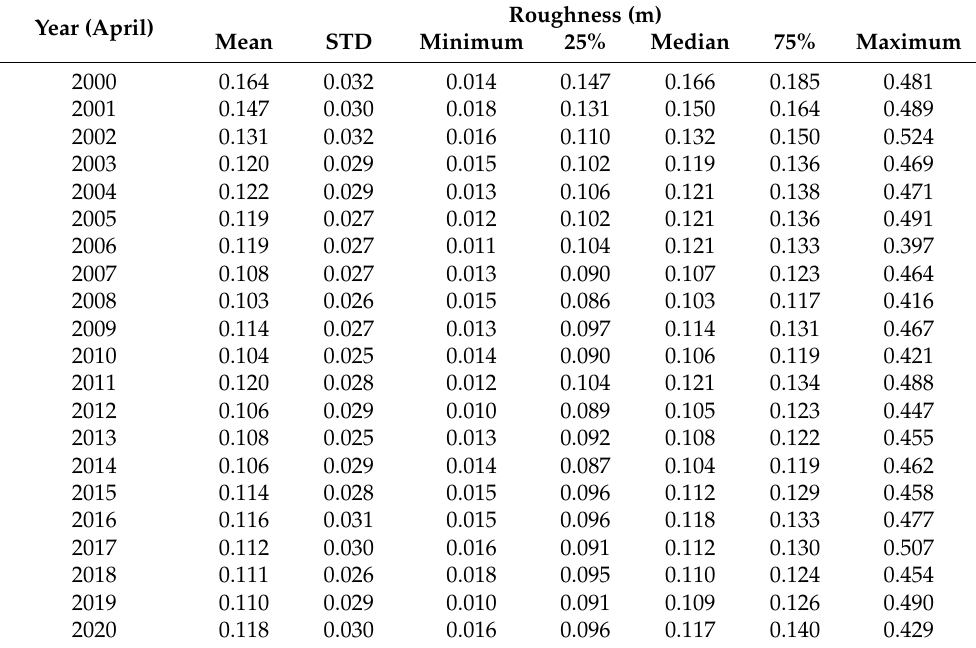
Table 5. A table showing roughness distribution grouped by year, for April